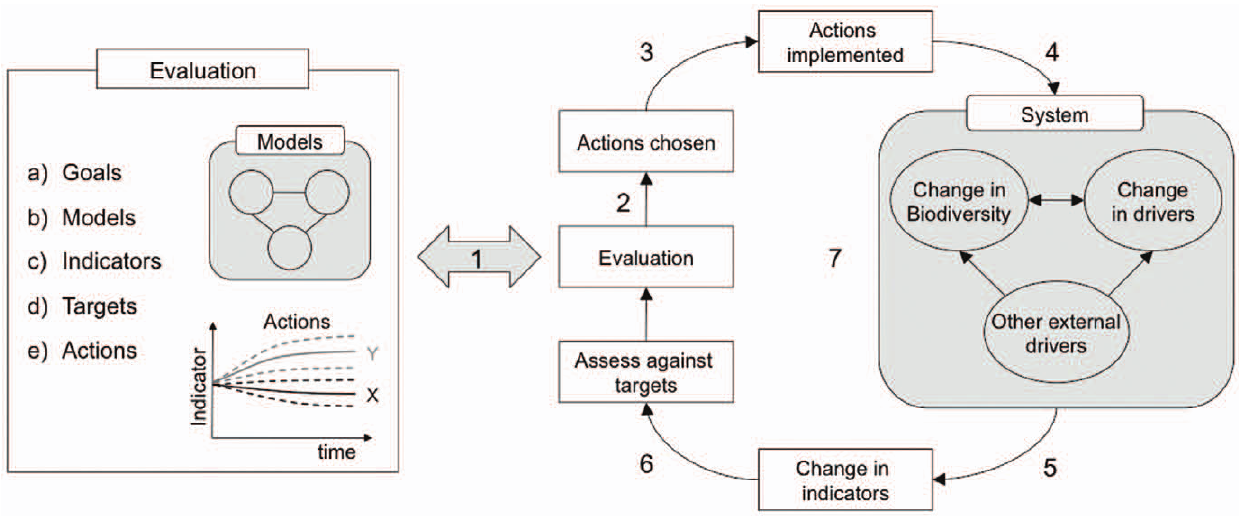
Figure 1. The indicator-policy cycle, a framework for using indicators to inform policy: Evaluation of the problem at hand involves defining broad goals of policy, developing models of the system, selecting indicators that reflect the changes of interest, defining specific targets that can be measured with the indicators, and defining a set of actions or policies to achieve the targets, which are assessed using the models. After evaluation, actions are chosen and implemented, with resultant change on biodiversity and drivers of loss, which may also be affected by other external drivers unrelated to the actions; change is monitored with the indicators and assessed against the targets, leading to re-evaluation. Key sources of uncertainty and potential failure throughout the cycle are numbered and discussed in detail in Table S1: 1) assumptions in the evaluation process; 2) the link between evaluation and selection of actions; 3) the link between selection and implementation of actions; 4) the impact of the action differing from the anticipated impact; 5) the link between biodiversity change and indicator change; 6) the link between indicator change and target assessment; and 7) mismatches in temporal and spatial scales throughout the cycle.